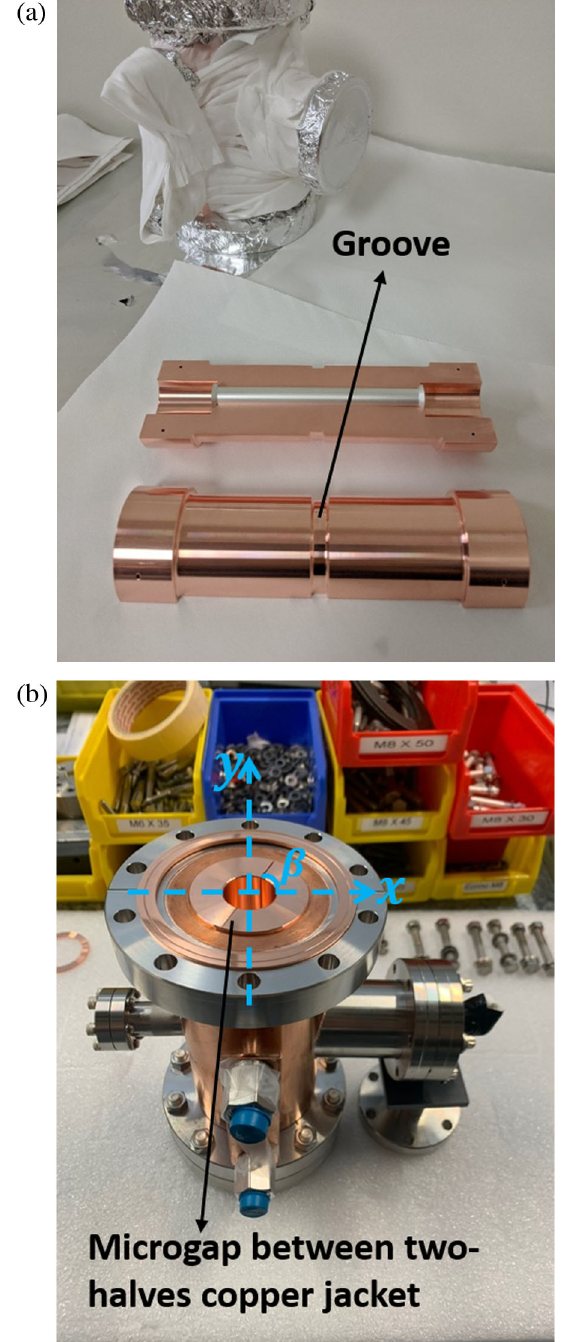
housing.FIG. 14. Prototypes of the mode converter with half-choke geometry (a) and conflat flange horizontal ( x -axis) and vertical ( y -axis) directions. For a microgap of 0.15 mm and the worst symmetry braking (an alignment angle β ¼ 45 o ), the simulated S 0 11 ¼ − 35 dB, S 0 21 ¼ − 0 . 75 dB. S 0 21 can be decreased to − 1 . 8 dB when this microgap equals to 1.0 mm. It should be noted here that the reflection coefficient S 0 11 ¼ ð S 11 þ S 13 þ S 31 þ S 33 Þ = 2